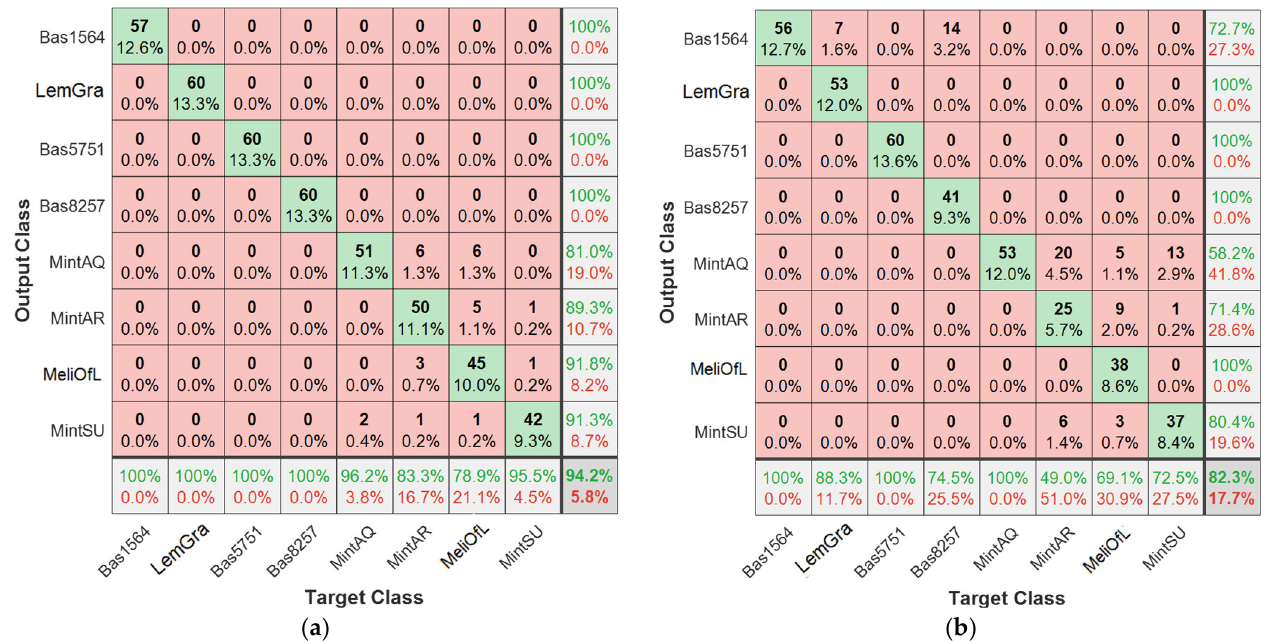
Figure 9. The discrimination ( a ) and prediction ( b ) confusion matrixes obtained from the k-NN analysis with 10-fold (k = 10) calculation using the unknown data sets from the second cycle to compare with the training data set (true labels) obtained from the first cycle.